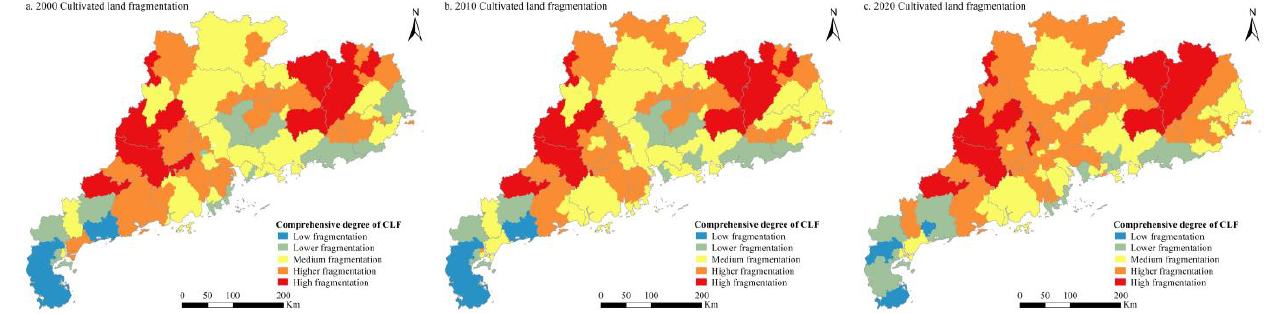
Figure 6. Spatial distribution of CLF in Guangdong Province on the county scale in 2000 ( a ), 2010 ( b ), and 2020 ( c ). The spatial distribution of CLF in Guangdong Province in 2000, 2010, and 2020 are displayed in ( a ), ( b ), and ( c ), respectively.